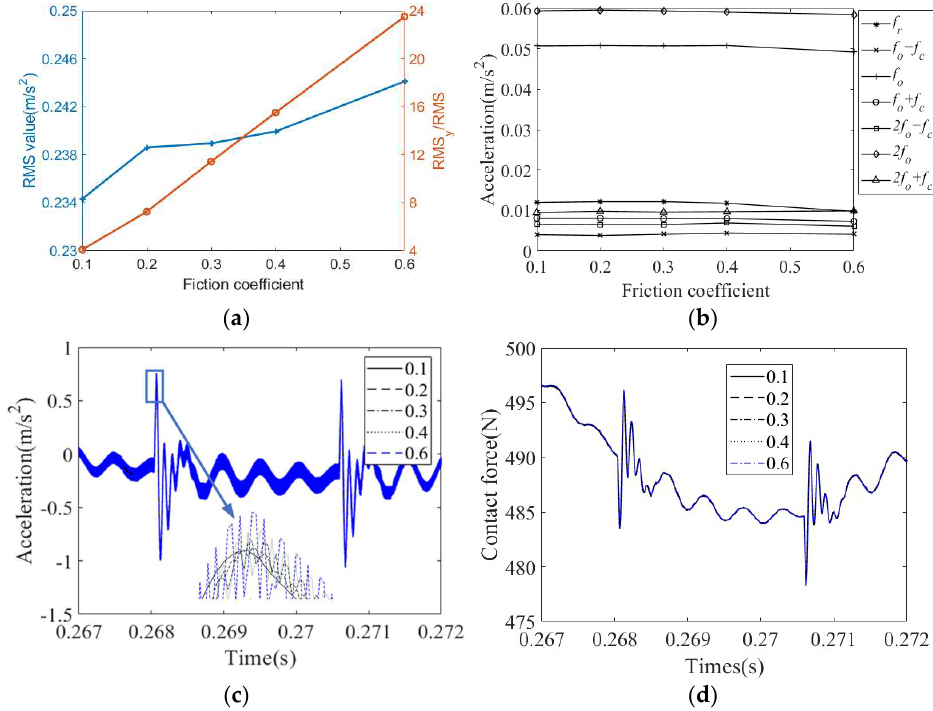
Figure 18. The vibration characteristics of the bearing under outer ring defect and friction coefficient: ( a ) RMS and RMS y /RMS; ( b ) amplitudes of f r , f o − f c , f o , f o + f c , 2 f o − f c , 2 f o , 2 f o + f c ; ( c ) housing acceleration signal from 0.267 s to 0.272 s; ( d ) contact force between outer ring and housing from 0.267 s to 0.272 s.